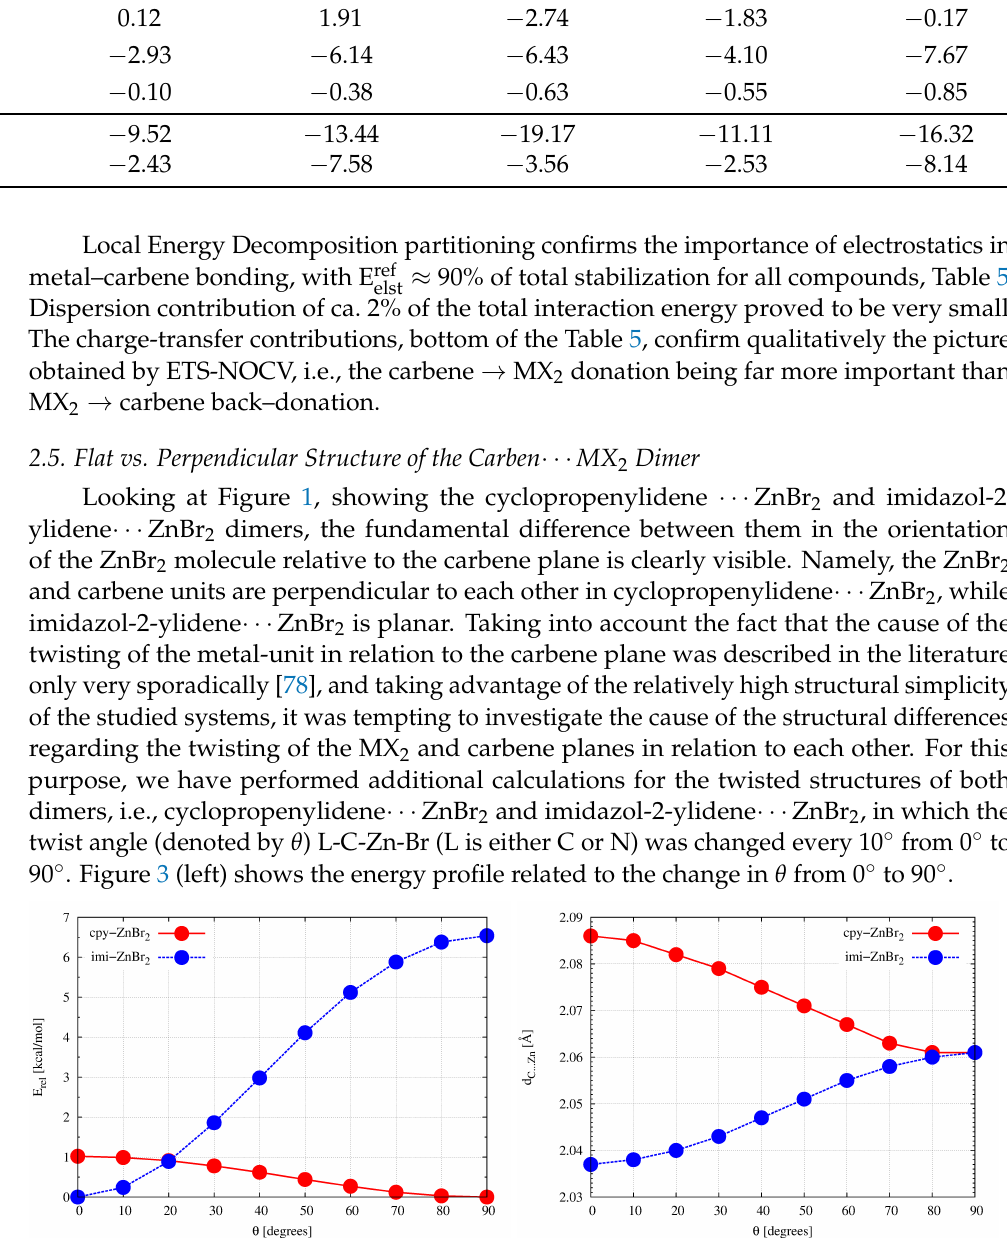
Figure 3. Relation between the relative energy (i.e., determined in relation to the minimum for a given dimer) (left) or the distance d C ··· Zn (right) and the twist angle of the ZnBr 2 unit plane with respect to the carbene plane for dimers cyclopropenylidene · · · ZnBr 2 (cpy-ZnBr 2 ) and imidazol-2- ylidene · · · ZnBr 2 (imi-ZnBr 2